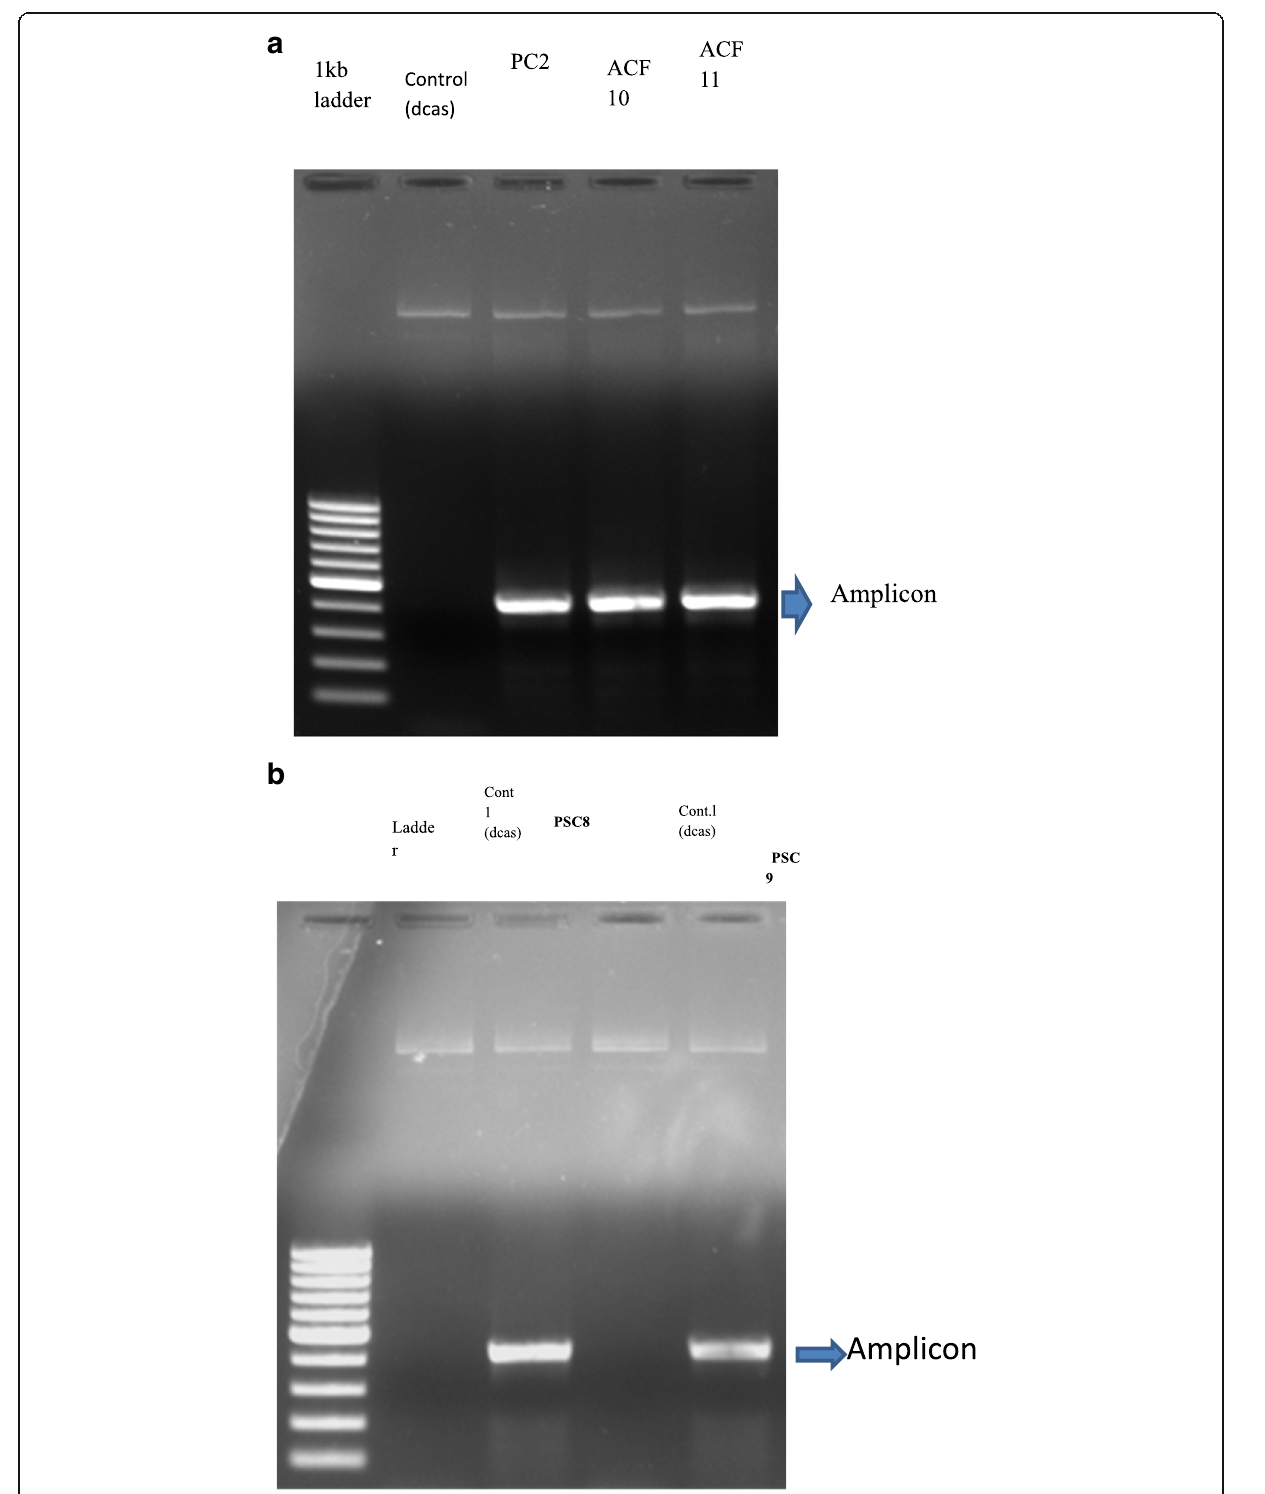
Fig. 8 a 1% agarose gel showing PCR confirmation of pAc-sgRNA-Cas9-puro-vector – positive construct for PC and ACF genes. b 1% agarose gel showing PCR confirmation of positive pAc-sgRNA-Cas9-puro-vector construct for PSC